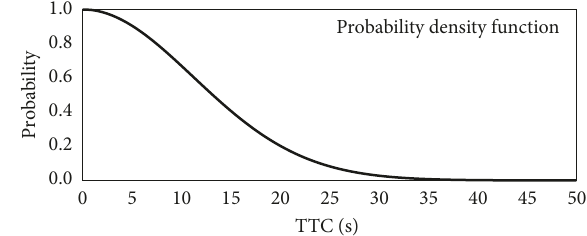
Table 1: The rules of the FIS.